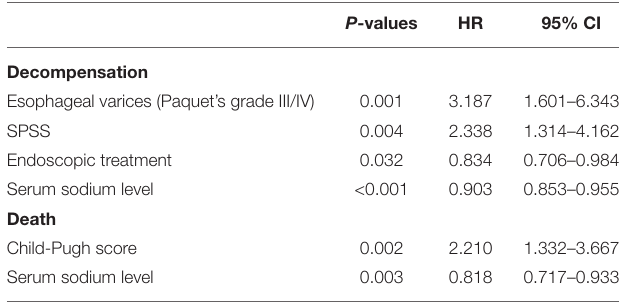
TABLE 1 | Characteristics of PVT in patients with cirrhosis. Patients with PVT ( n = 117)